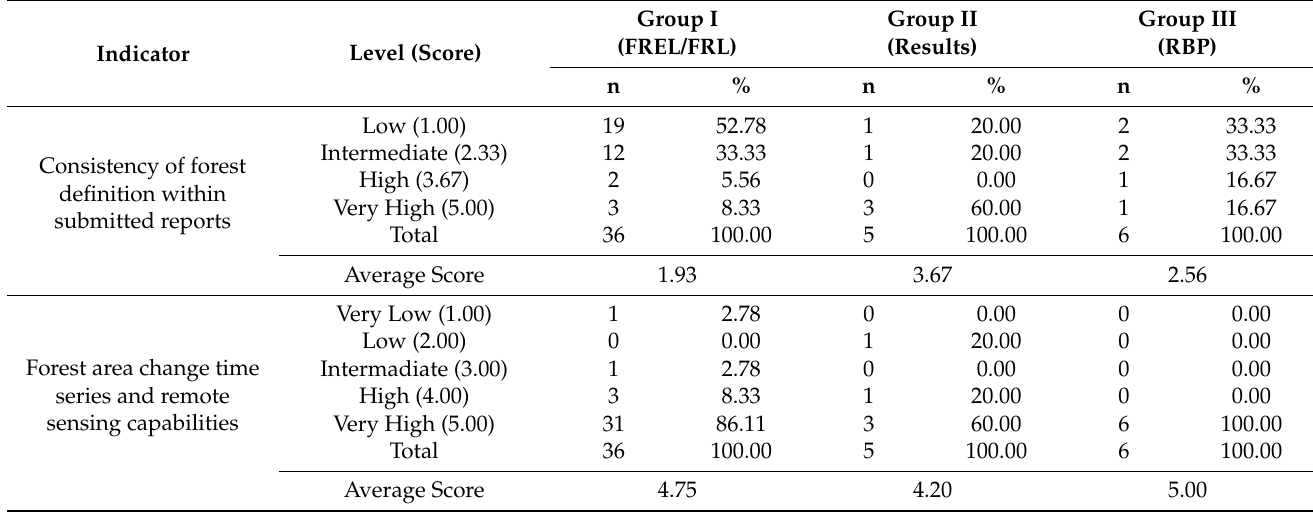
Table 6. Results of MRV capacity evaluation on the National Forest Monitoring System.